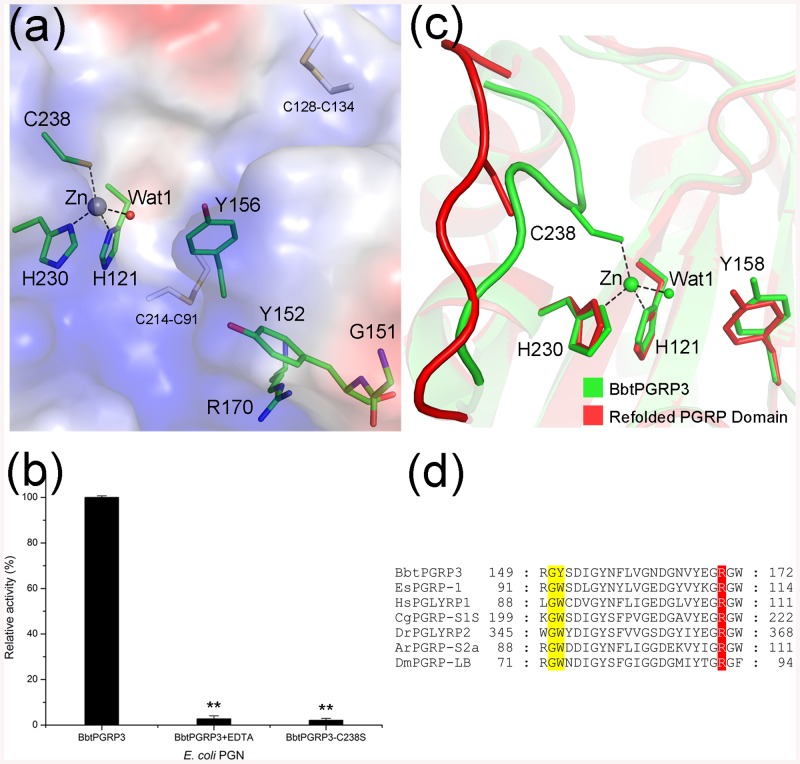
The C-terminal amidase domain of BbtPGRP3.(a) Surface representation of the BbtPGRP3 C-terminal PGRP domain. The zinc ion and its coordinating water molecule are displayed as lightblue and red spheres, respectively. The active-site residues and putative residues related to PGN-binding specificity are shown as sticks and colored in green. (b) Reactions containing RBB-labeled E. coli PGNs were incubated with 50 nM wild-type BbtPGRP3, EDTA-treated BbtPGRP3 and BbtPGRP3-C238S, respectively. Undigested PGNs were pelleted by centrifugation and the absorbance of the supernatants at 595 nm were determined. Results of activity are expressed as the percentage to the wild-type BbtPGRP3. The values are expressed as mean values ± SD of three independent experiments. All data were analyzed by t-test, and the statistical significance of the differences between experimental and a control group is shown with asterisks (**P<0.005). (c) Superposition of PGRP domain from full-length BbtPGRP3 against the refolded PGRP domain. The full-length BbtPGRP3 and refolded PGRP domain are colored in green and red, respectively. The zinc ion and its coordinating water molecule are displayed as spheres and the active-site residues are shown as sticks. (d) Multiple-sequence alignment of specificity-determining residues of PGRPs. Residues corresponding to Gly150/Tyr151 and Arg170 of BbtPGRP3 are highlighted in yellow and red, respectively. The sequences are (NCBI accession numbers codes in parentheses) Branchiostoma belcheri tsingtauense BbtPGRP3 (KR136228), Asterias rubens ArPGRP-S2a (ABB04460.1), Crassostrea gigas CgPGRP-S1S (BAG31896.1), Drosophila melanogaster DmPGRP-LB (NP_650079.1), Danio rerio DrPGLYRP2 (NP_001038631.1), Euprymna scolopes EsPGRP-1 (AAY27973.1) and Homo sapiens HsPGLYRP1 (NP_005082.1).